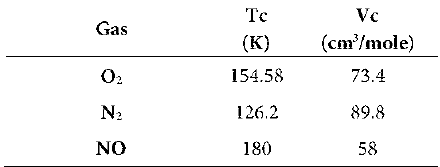
Table 1. Penetrant Critical Temperatures, Critical Volumes